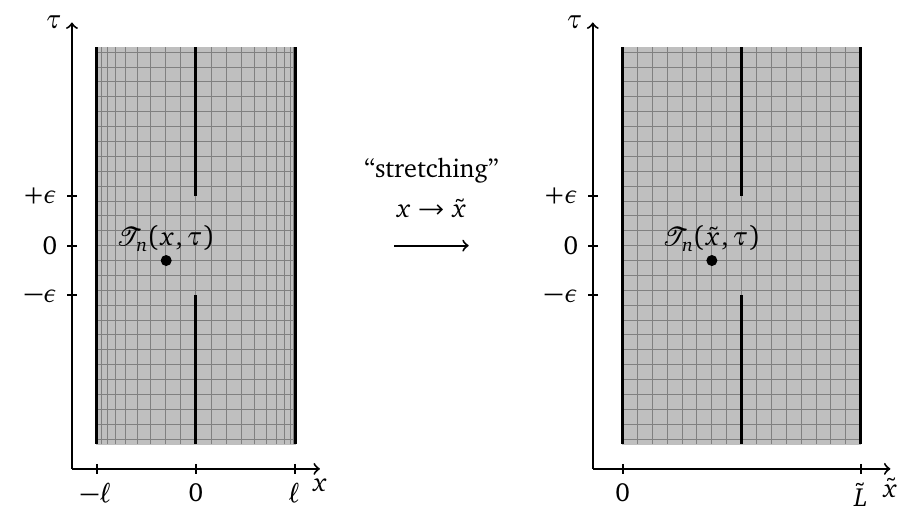
Figure 4: The euclidean spacetime geometry needed for the calculation of the evolution of the entanglement entropy after a “cut-and-glue” quench in the center of a harmonic trap (left). The system is inhomogeneous, with a spacetime metric ds 2 = d x 2 + v ( x ) 2 d τ 2 . In stretched coordinates ˜ x (right), the metric is ds 2 = e 2 σ [ d ˜ x 2 + d τ 2 ] with e σ ( x ) = v ( x ) , so it can be made flat with the Weyl transformation g µν → e − 2 σ g µν . This is the trick on which we rely to adapt ( ˜ x , τ ) 〉 from Ref. [ 23 ] to this inhomogeneous the calculation of the one-point function 〈(cid:84) n